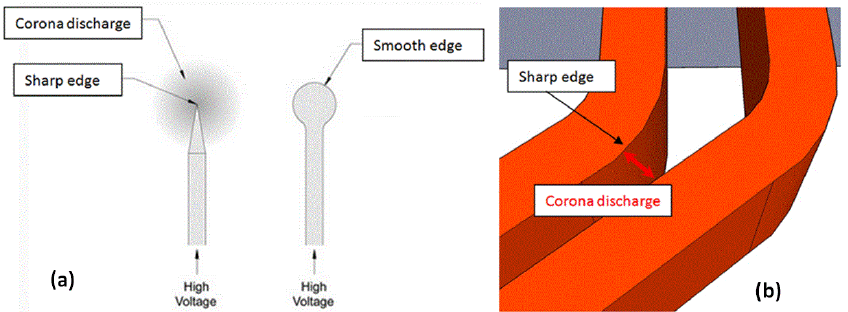
Figure 19. Corona discharges start from sharp edge. Even if the distance from surfaces is large enough, the electrical field magnitude increases locally ( a ). Outside of the slot, the coils are bent and the handmade process can initiate sharp edges. It is not unusual to discover insulation wall affected by corona discharges in the first section of the outside area ( b ). This effect appears essentially for coils which are connected to different phases.